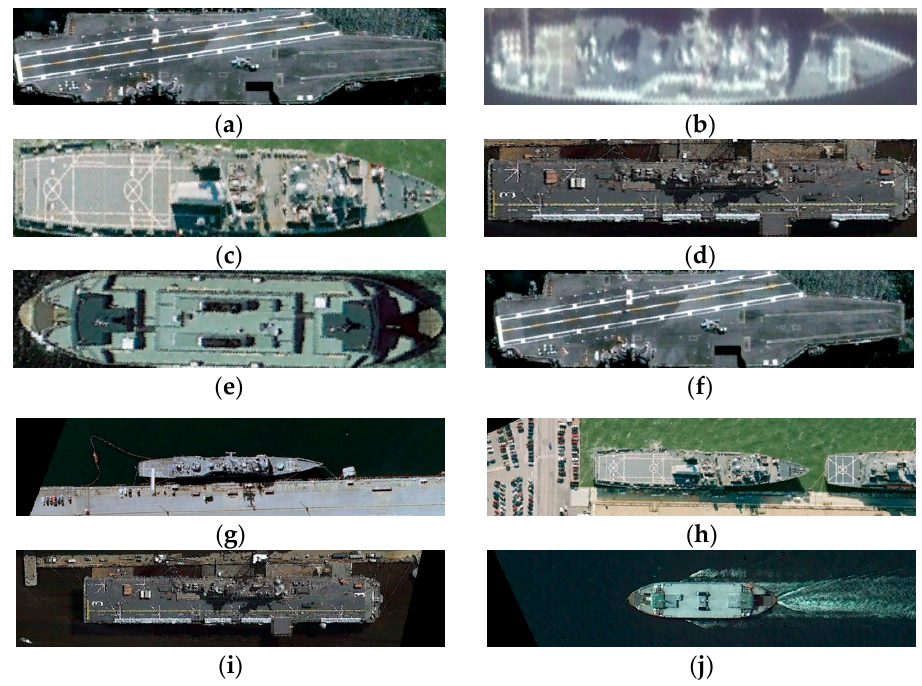
Figure 7. Ship slices from two slices sets of dataset 2. ( a – e ) are from slices set 1 of dataset 2, and ( f – j ) are from slices set 2 of dataset 2.